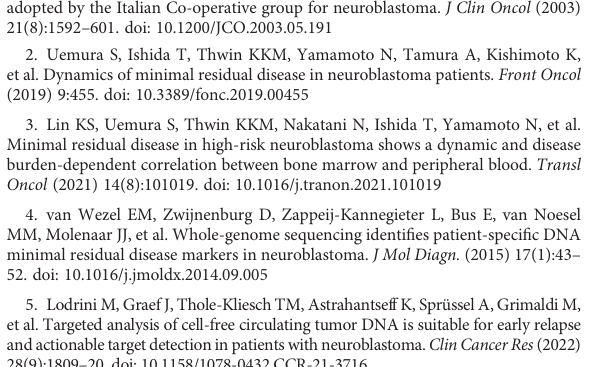
SUPPLEMENTARY FIGURE 1 (A) Representative image of enriched live NLF neuroblastoma cells (arrows) from ClearCell ® FX output, isolated using micro fl uidic single-cell capture device (scale bar: 20µm). (B) Expression of neuroblastoma gene markers and housekeeping genes in 15 captured single NLF cells, demonstrating highest expression of PHOX2B and TH, followed by GD2 synthase. (C) Relative gene expression of PHOX2B, TH and GD2 synthase in 7 neuroblastoma cell lines in comparison with non-neuroblastoma cell line AGS. NB: neuroblastoma; GC: gastric cancer. SUPPLEMENTARY FIGURE 2 HeatmapsofPearsonz-scoresofgenesfromthe (A) PanCancerPathwayand (B) PanCancer Progression panels, of 17 patients at initial diagnosis, as well as normalcontrolsofperipheralbloodsamplesfrom3healthysubjects,showing segregation of cases with gene expression patterns similar or dissimilar to normal controls (red and green, respectively) on unsupervised hierarchical clustering. (C) Counts of atypical cells identi fi ed in each ¼ CTC-enriched fraction demonstrating immuno-positivity or negativity for PHOX2B and TH. SUPPLEMENTARY FIGURE 3 Heatmap of log 2 normalized counts of all 1490 cancer-related genes, clustered according to clinical and pathological variables and sites of metastases (Euclidean unsupervised hierarchical clustering). INPC: International Neuroblastoma Pathology Classi fi cation system. Clusters indicating upregulated genes in patients with bone marrow metastases and relapse are indicated in dashed lines. SUPPLEMENTARY FIGURE 4 (A) MA (Bland – Altman) plots comparing means of normalized counts against the log fold change of genes from the PanCancer Pathway and Progression panels of enriched CTC fractions of 17 neuroblastoma patients. Colored points indicate genes with signi fi cant differential expression between patients with and without bone marrow metastases, at adjusted p-value threshold of 0.05. (B) Corresponding principal component analysis score plots of patients with and without bone marrow metastases. SUPPLEMENTARY TABLE 1 Clinical and pathological characteristics of study patients. SUPPLEMENTARY TABLE 2 Correlation of clinicalvariables withnumbersof cells withcytologic atypia in peripheral blood CTC-enriched fractions at initial diagnosis (bold,